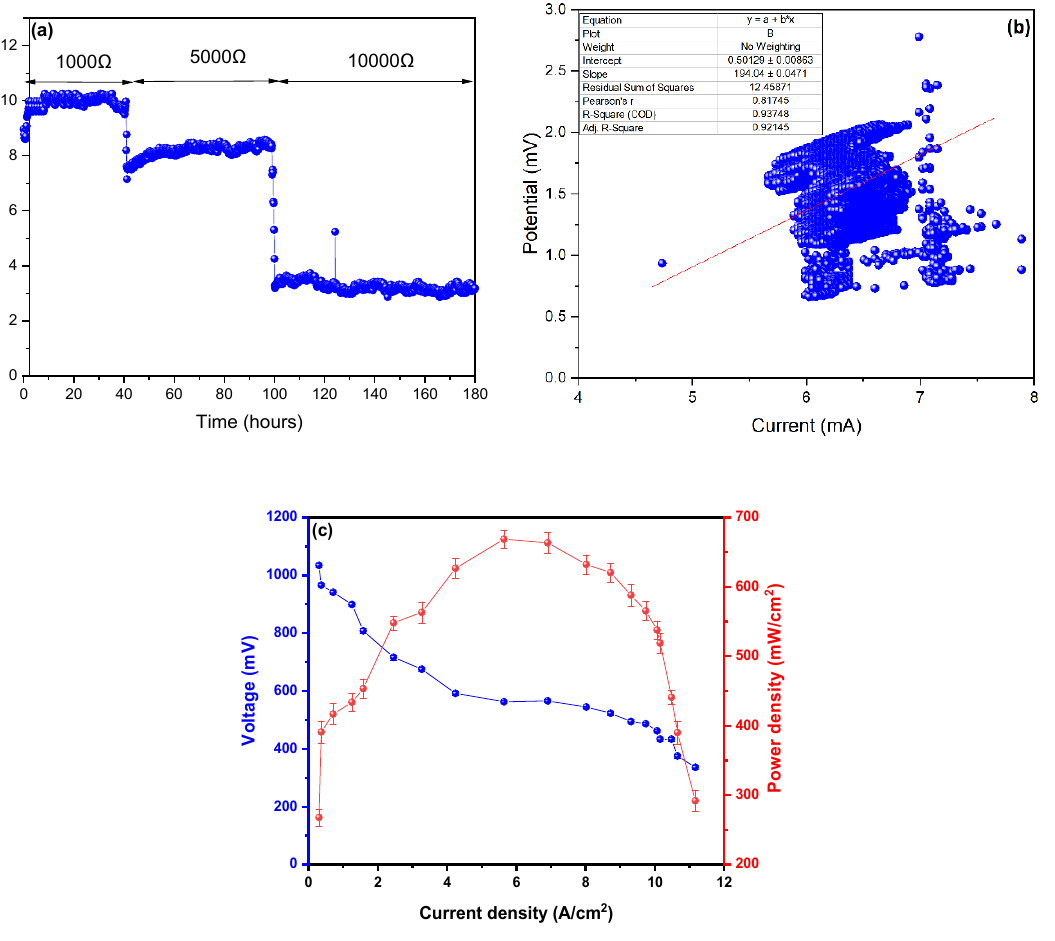
Figure 4. ( a ) Power, ( b ) internal resistance and ( c ) power density versus current density of MFC. In Figure 5, the variation between the initial and final FTIR spectra of the substrate waste is shown. The most intense band around 3275 cm − 1 corresponds to those of OH stretching, corresponding to polysaccharides or lignins [38]. Symmetric and asymmetric stretching vibrations of CH 2 groups are found at 2920 and 2853 cm − 1 , which are mainly associated with lipid hydrocarbon chains [39]. Similarly, the bands around 1635 cm − 1 are associated with the stretching of C=OO − groups and C=C aromatic groups (phenolic compounds) [3]. The region between the bands from 1030 to 1540 cm − 1 corresponds to organic compounds, such as sugars, alcohols, and organic acids, present in the sample [40]. The decrease in the band intensity of the spectrum of substrate waste is mainly due to the fact that many organic compounds were consumed or degraded by breaking the chemical bonds in bioelectricity generation during the monitoring of the MFCs